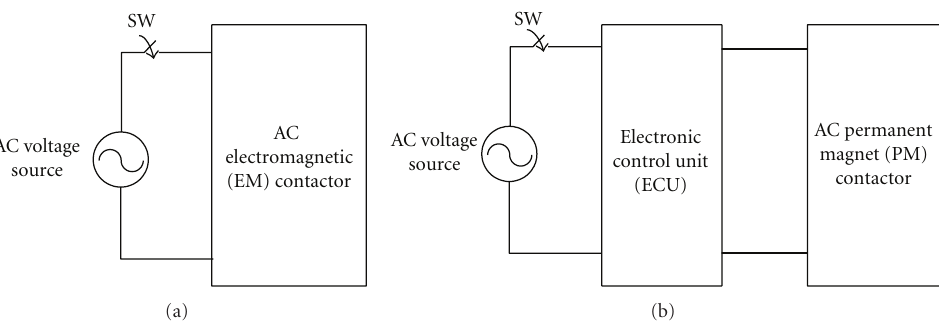
Figure 1: Sketch the structure of an (a) AC EM contactor; (b) AC PM contactor.